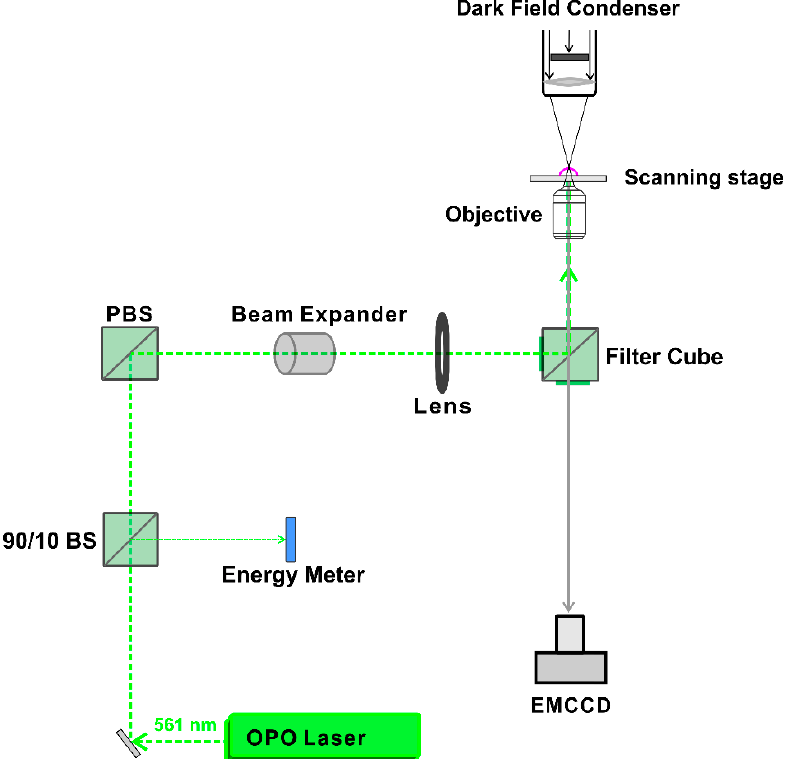
Figure 10. Optical design for generation and detection of heating and VNB formation. AOTF: acousto-optic modulator to control the power of the continuous wave laser. OPO laser: pulsed laser with ~7 ns pulses equipped with an Optic Parametric Oscillator that allows for tuning the wavelength from 410 to 2200 nm. 90/10 BS: laser beam splitter that reflects 10% and transmits 90% of the laser light. PBS: polarization beam splitter. Image adjusted with permission from [20] © American Chemical Society.